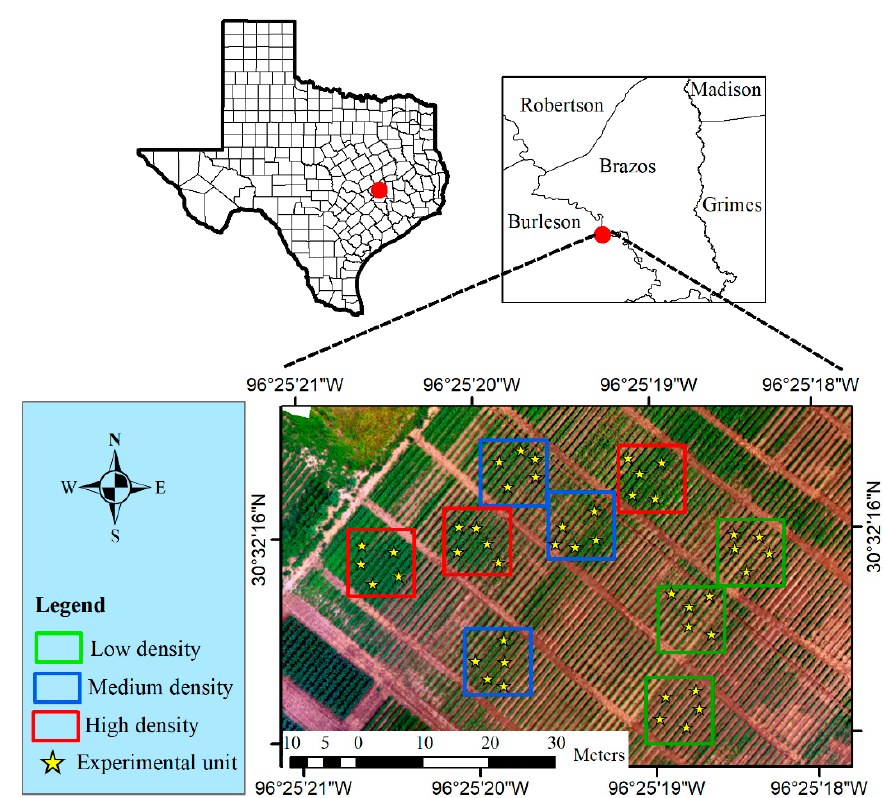
Figure 1. The experimental field (0.6 ha) with spatial distribution of treatment plots representing low (green polygons), medium (blue), and high (red) weed densities. Yellow star within the density plots represent the location for experimental unit, which is a quadrat (1 m × 1 m) in our case. Each treatment plot has five experimental units.